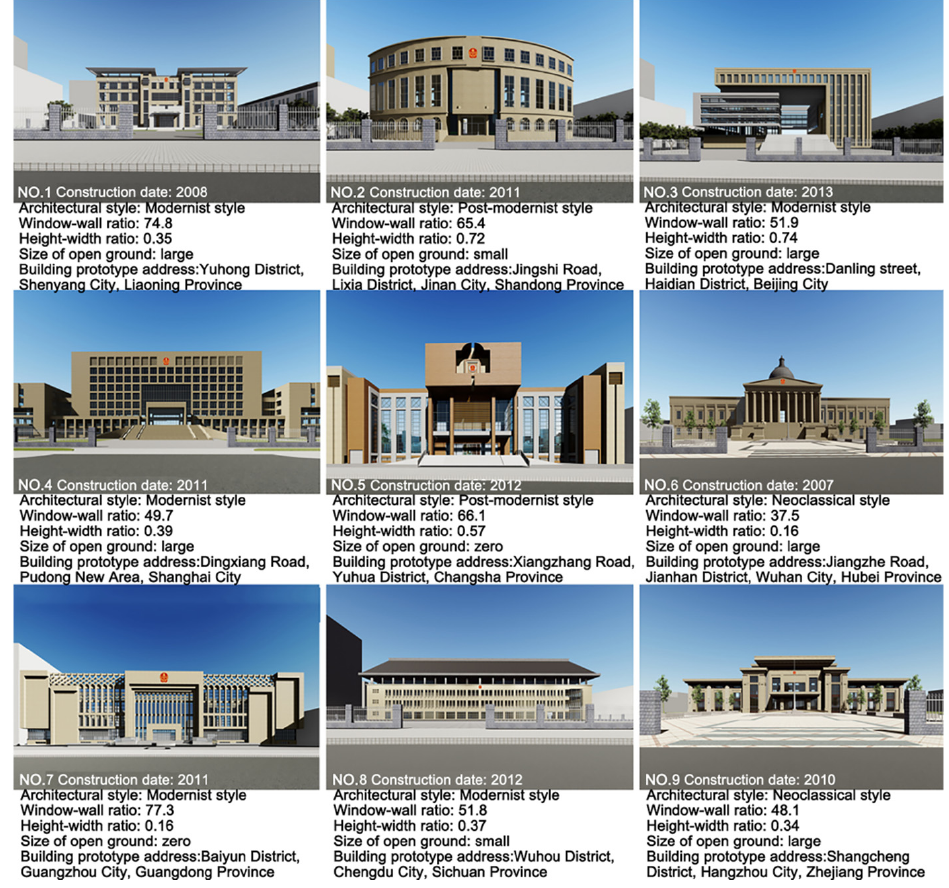
Figure 1. The nine photos of the Chinese courthouse